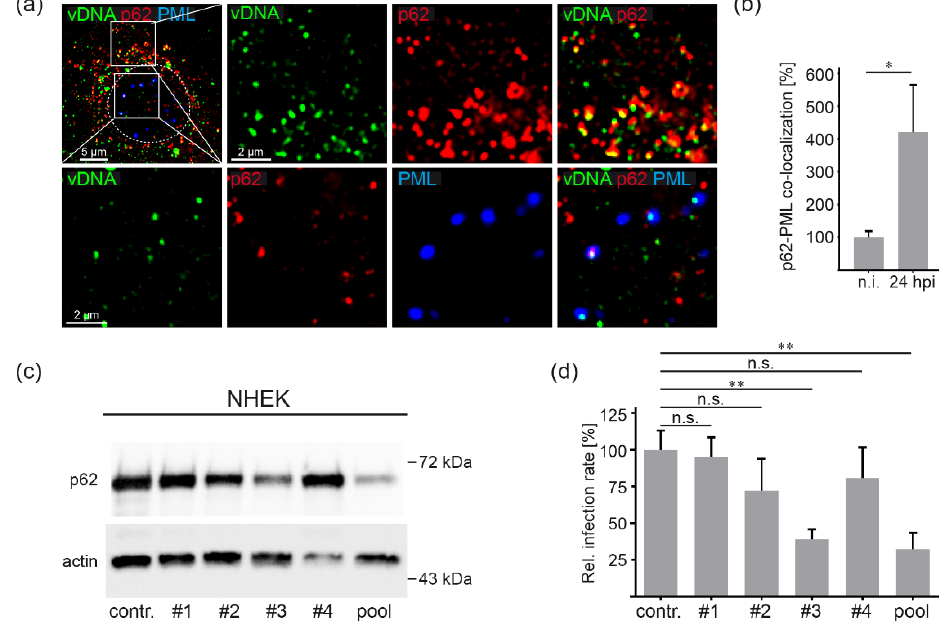
Figure 5. HPV16 PsV infection in primary keratinocytes involves p62. ( a ) Representative pictures of vDNA (green), p62 (red) and PML (blue) co-localization in primary keratinocytes. NHEKs were treated with EdU-labeled HPV16 PsVs for 24 h and stained with p62- and PML-specific mAbs. Pictures show higher magnification of vDNA-p62 co-localization in the cytoplasm (upper panel) or vDNA-p62-PML co-localization in the nucleus (lower panel) as outlined by boxes in the first panel (top left). ( b ) Relative co-localization of p62 and PML in NHEK cells. NHEKs were incubated with EdU-labeled HPV16 PsV for 24 h and stained with p62- and PML-specific mAbs. P62 pixels co-localizing with PML pixels are given as a mean ± SEM, and the mean for non-infected cells (n.i.) was set to 100%. Data ( n = 57–60 out of three replicates) were analyzed for significance using Mann–Whitney test; p = 0.0251. ( c , d ) NHEKs were transfected with control (contr.) or p62-specific siRNAs as indicated for 48 h and incubated with HPV16 LCR PsVs for an additional 24 h. ( c ) Knockdown efficiency was analyzed by Western blotting using p62-specific mAb 48 h after siRNA transfection. β -actin was used as loading control. ( d ) Relative infection rates were assessed by luciferase activity and normalized to LDH activity as cell viability control. Infection rate is given as mean ± SEM, and the mean for control siRNA-treated cells was set to 100%. Data ( n = 7–9 out of three replicates) were analyzed for significance using non-parametric ANOVA (Kruskal–Wallis test): p < 0.0036. Comparison for groups of interest is marked, and p values were calculated using unpaired t test ( p > 0.05 for contr. vs. siRNA#1, p > 0.05 for contr. vs. siRNA#2, p > 0.05 for contr. vs. siRNA#4, p = 0.0015 for contr. vs. siRNA pool) and Mann–Whitney test ( p = 0.0055 for contr. vs.